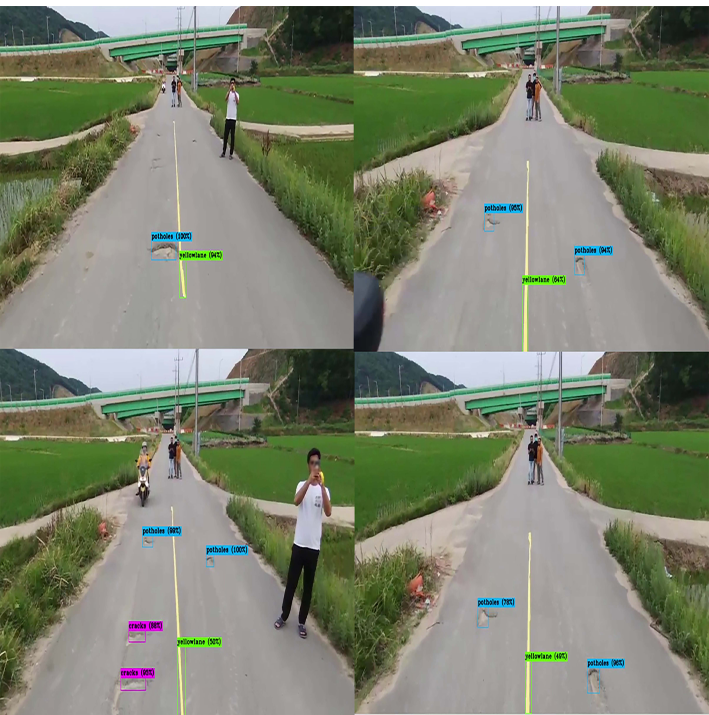
Figure 14. Real-time results of improved model.